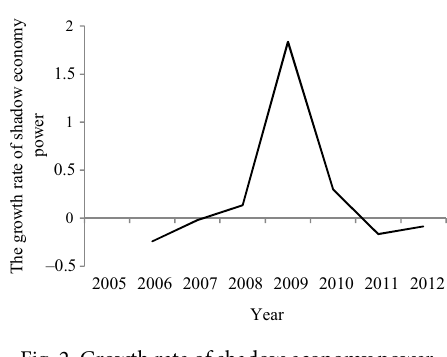
Fig. 1. Dynamics of shadow economy power in Lithuania